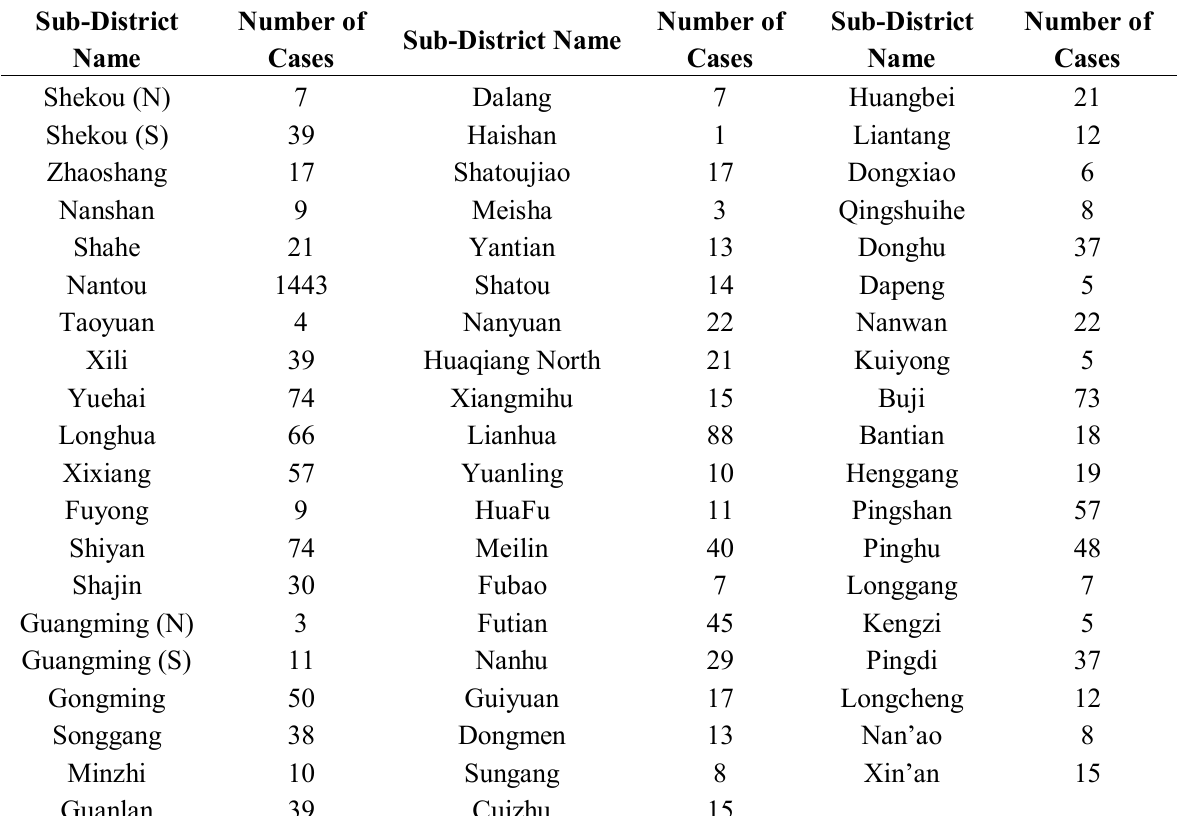
Table 2. The number of hepatitis B cases in each